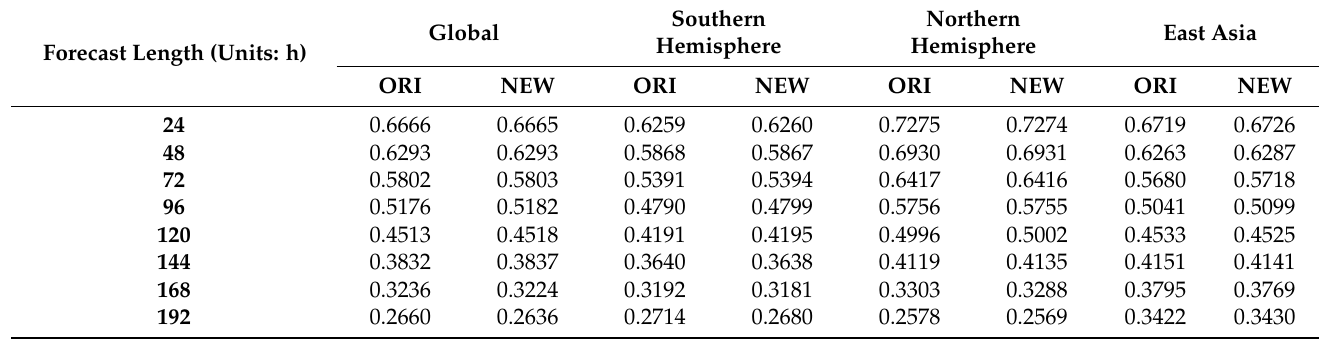
Figure 7. Same as Figure 3, but for ACC of air temperature at 2 m. In addition, we further calculate the area-averaged ACC over global, Northern Hemi- sphere, Southern Hemisphere, and eastern Asia, respectively. As shown in Table 4, the ACC of 2 m air temperature decreases rapidly as the forecasting hours increase, and the predictable duration is about 3 days on a global scale. The ACC over eastern Asia is generally higher than other regions, with the values ranging from 0.6726 to 0.3422, which denotes a more stable prediction result for eastern Asia. The ACC values derived from GRAPES_NEW show improvements of forecasts within 5 days compared to GRAPES_ORI, and the similar results can also be obtained from the analysis for RMSE (not shown). Table 4. ACC of 2 m air temperature between GRAPES forecast and ERA5 over different